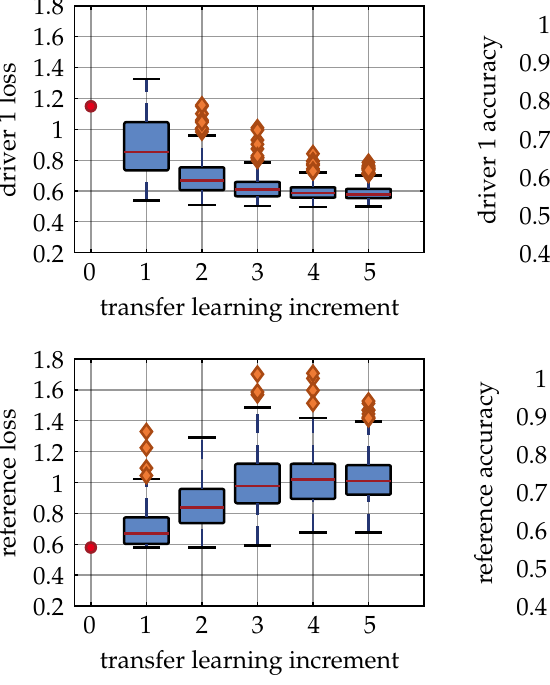
Figure 8. Training results for driver 1 (calm).